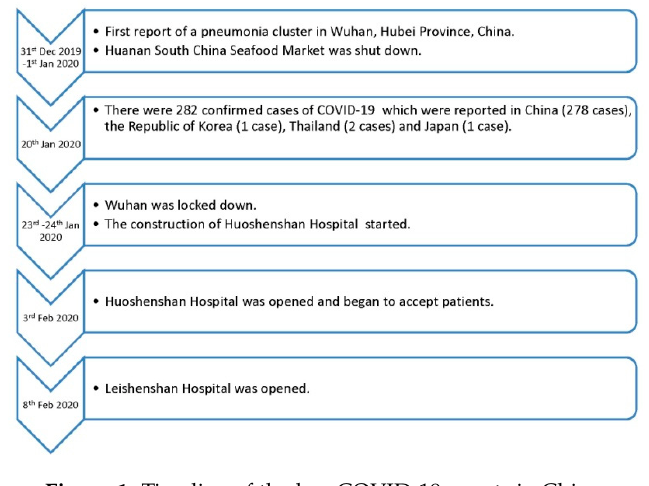
Figure 1. Timeline of the key COVID-19 events in China.